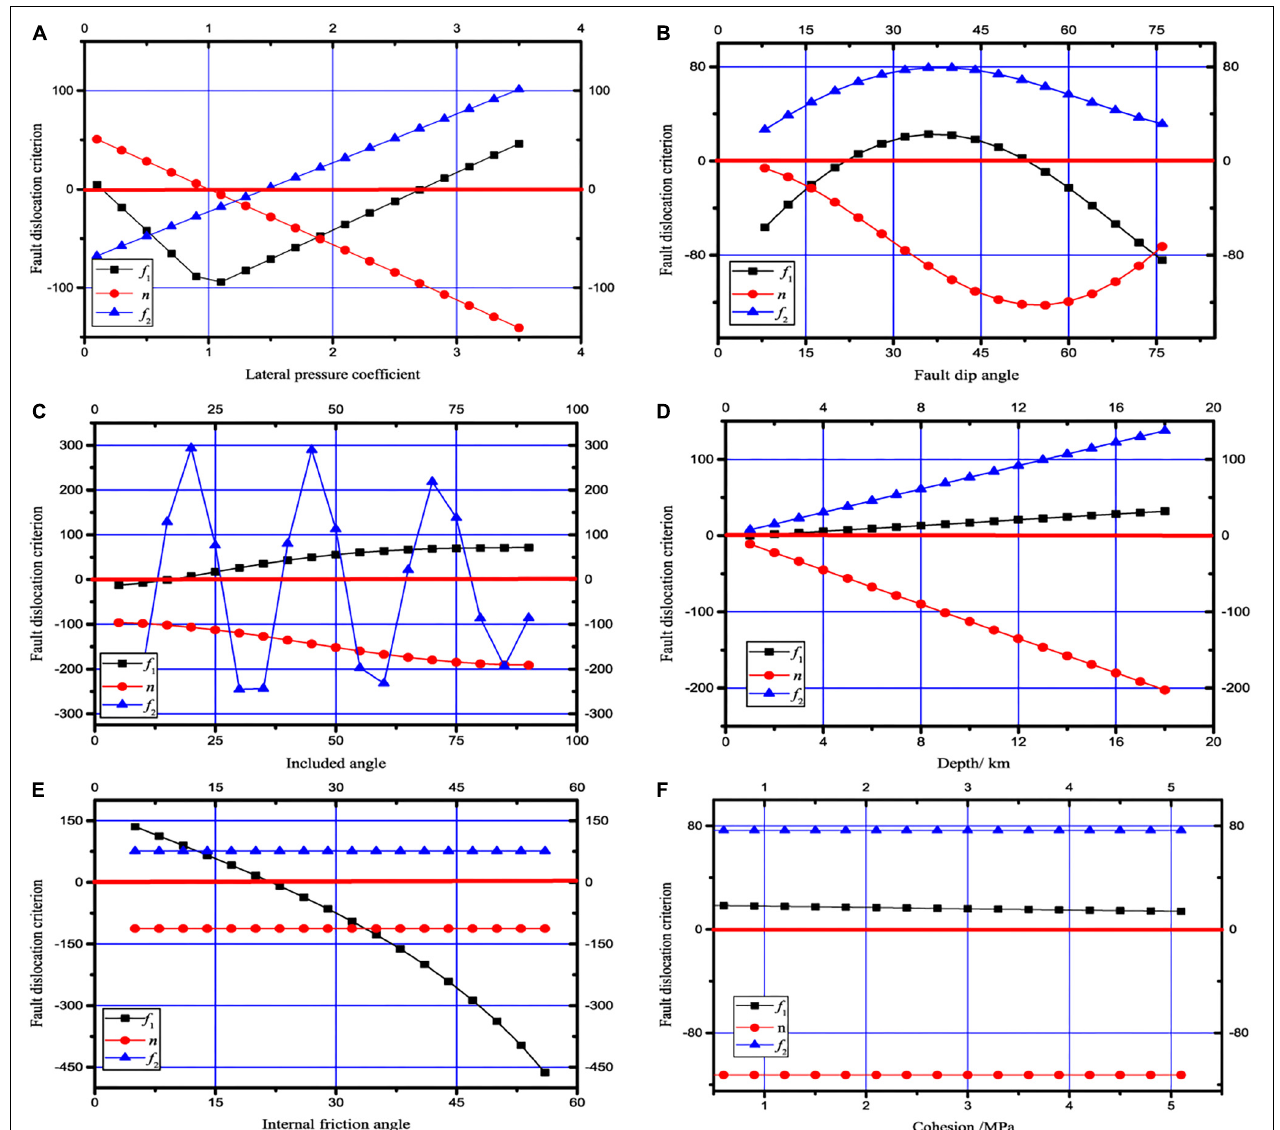
FIGURE 2 | Numeric diagram of fault slip criterion under different parameters. Given a set of data, the dip angle of the fault is θ = 45 ◦ , the angle between the direction of principal stress σ 1 and the strike of the fault is ϕ = 25 ◦ degrees, the depth H = 10 km, the lateral pressure coefficient is λ = 3, the friction angle in the fault plane is ϕ = 20 ◦ , the cohesion force is 2 MPa, σ 3 = γ H , and σ 2 = 0.5 (1 + λ ) σ 3 . (A) Fault dislocation criterion under different lateral pressure coefficients, (B) fault dislocation criterion under different fault dip angles, (C) fault dislocation criterion under different included angles, (D) fault dislocation criterion under different depth, (E) fault dislocation criterion under different internal friction angles, (F) fault dislocation criterion under different